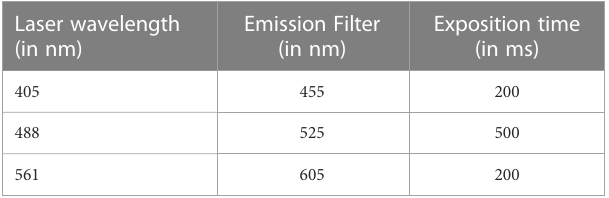
TABLE 1 Exposure parameters of image acquisition using the InCell Analyzer. Laser wavelength (in